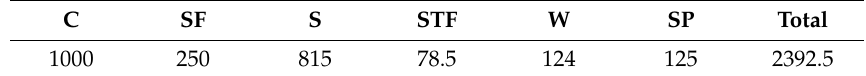
Table 2. Mix proportions of cementitious composite (kg/m 3 ).